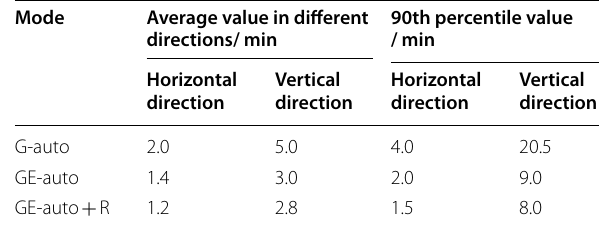
Table 2 Average and 90th percentile convergence time for “AR”, “G-GIM”, “G-1 cm”, “G-8 cm”, “G-30 cm” and “G-auto” solutions Average value in different directions/ min